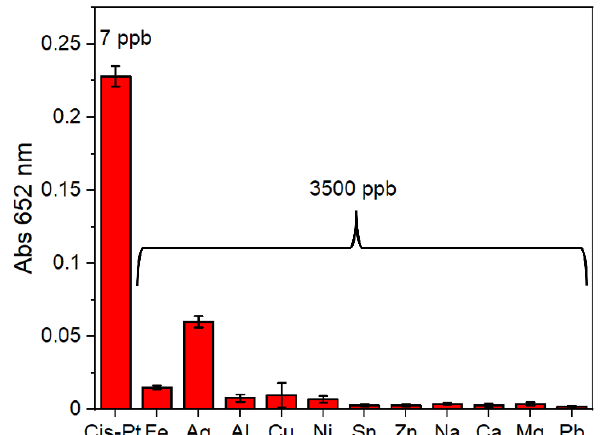
Figure 3. Selectivity of the colorimetric assay with respect to other toxic metal cations, in terms of absorbance signal measured after 5 min of reaction. Results are expressed as mean ± SD of tripled experiments.